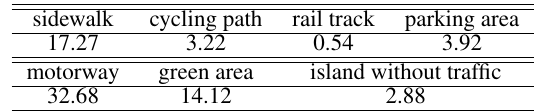
Table 1. Number of points ( · 10 6 ) in each road